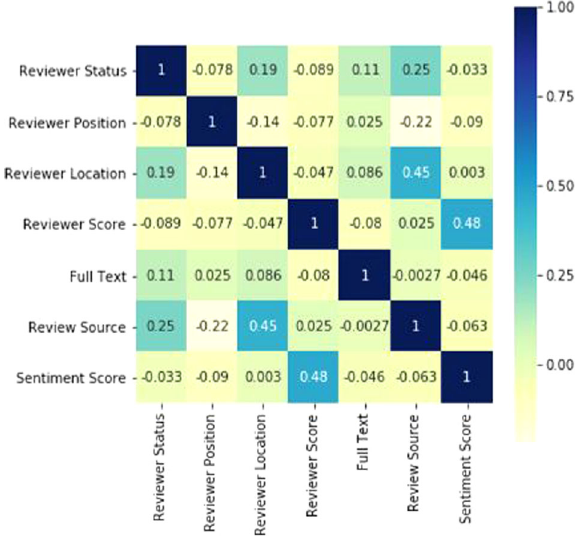
Fig. 5 Correlations between properties are shown. Dark blue squares indicate that properties on the x and y axes are more correlated. When both features are added to the training data, higher correlation leads to a possible negative impact on the classi fi cation